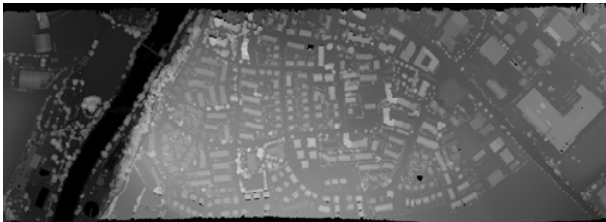
Figure 3. (a) LiDAR data